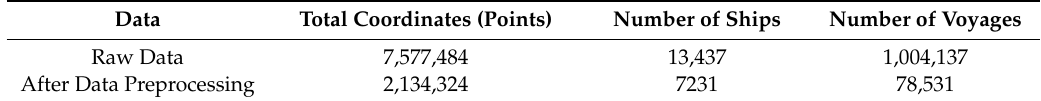
Table 1. Comparison before and after data processing.